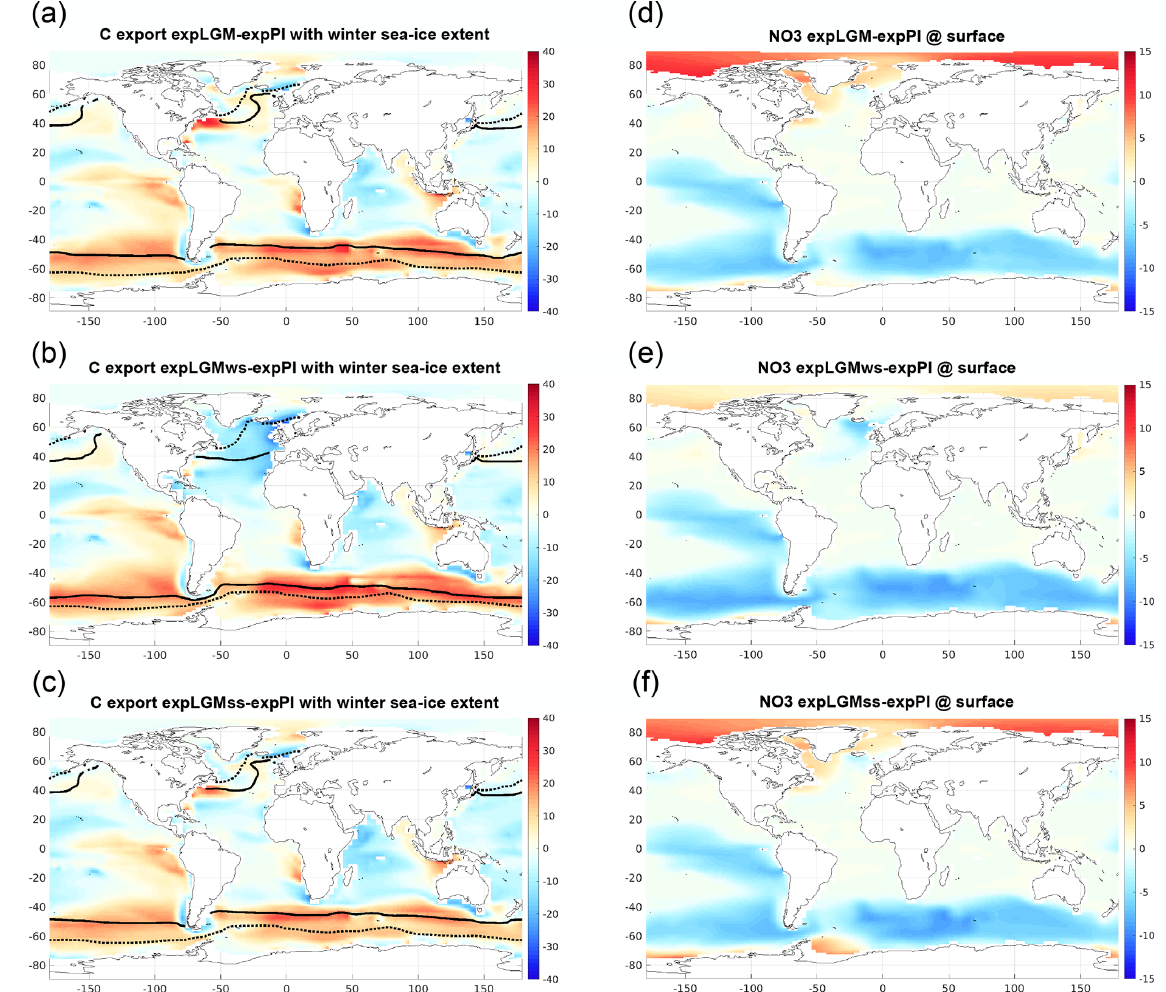
Figure 10. Carbon export at a depth of 100m ( a–c ; gCm − 2 yr − 1 ) and the concentration of nitrate at the surface ( d–f ; mmolm − 3 ). The differences from those in expPI are shown for each of the LGM runs: expLGM (a, d) , expLGMws (b, e) , and expLGMss (c, f) . In panels (a) – (c) , the maximum extent of sea ice during the winter season of the respective hemisphere is also shown as solid lines (LGM) and dotted lines (PI). The average states in the last 50 years are